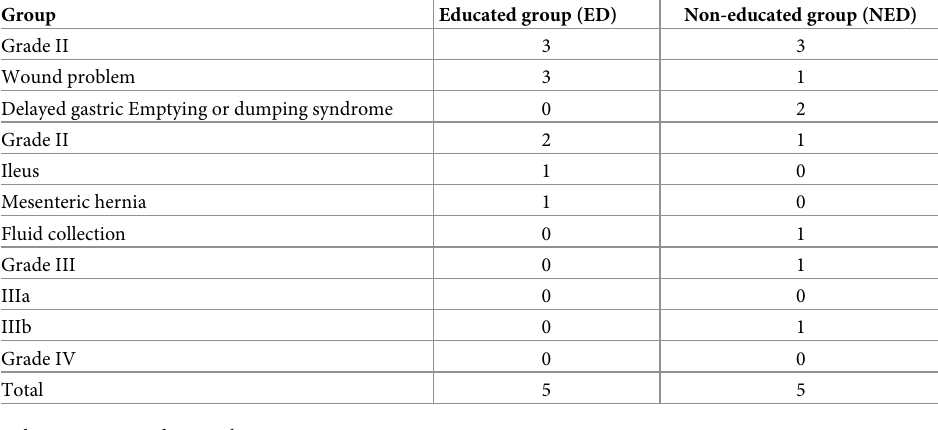
Table 2. Postoperative